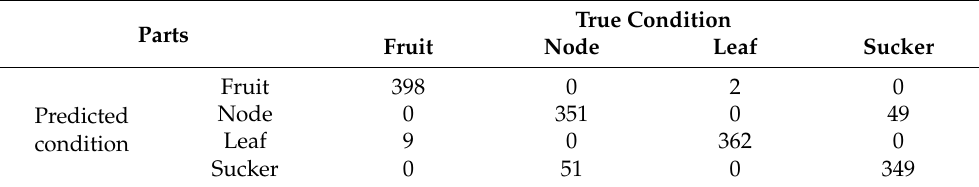
Table 8. Result of the CNN algorithm.